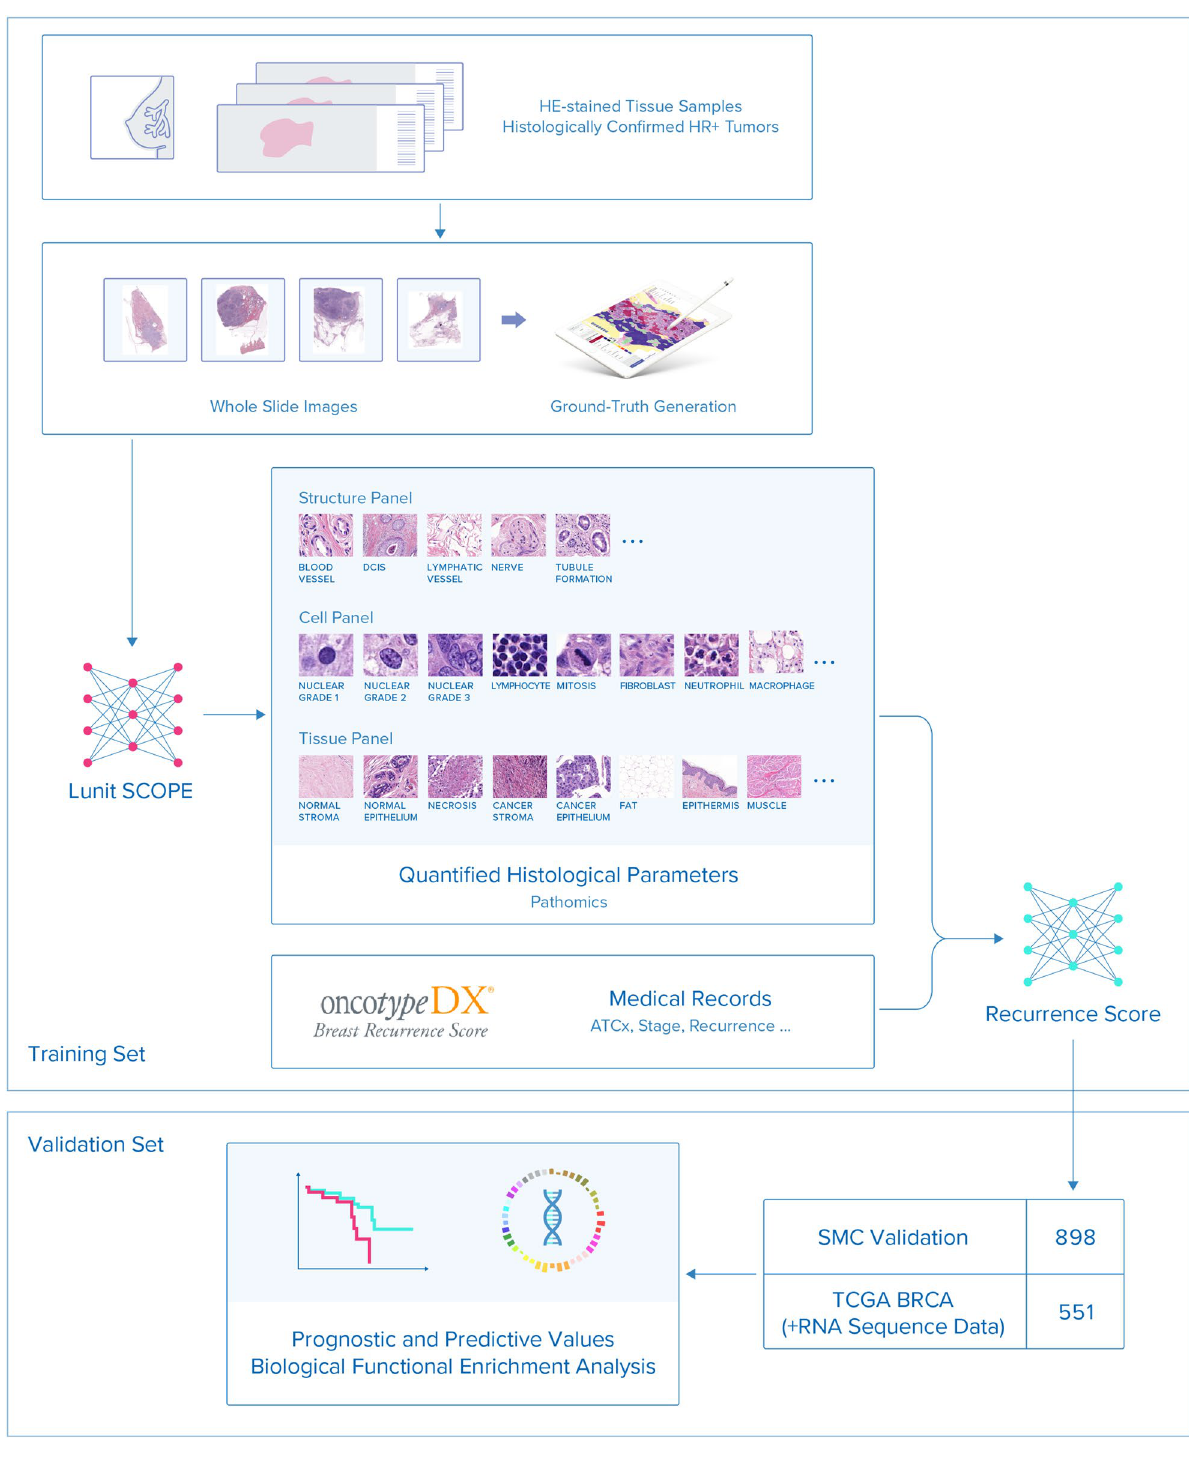
Figure 1. Schematic representation of Lunit SCOPE development and the workflow scheme of this